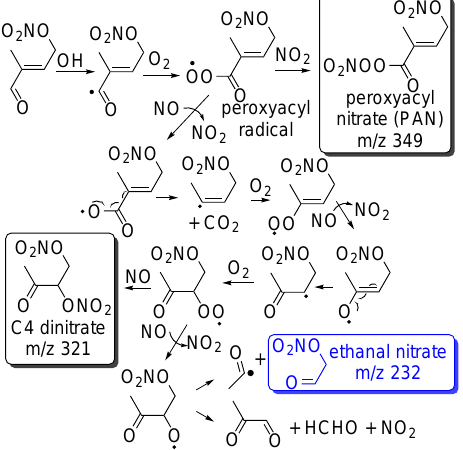
Figure 11. A proposed reaction mechanism for the H abstraction pathway for the OH + nitrooxy enal oxidation reaction. The com- pounds in boxes are products inferred from the nominal masses ob- served by the CIMS (Fig. 8). The compound colored in blue was observed by both GC and CIMS (Fig. 13).